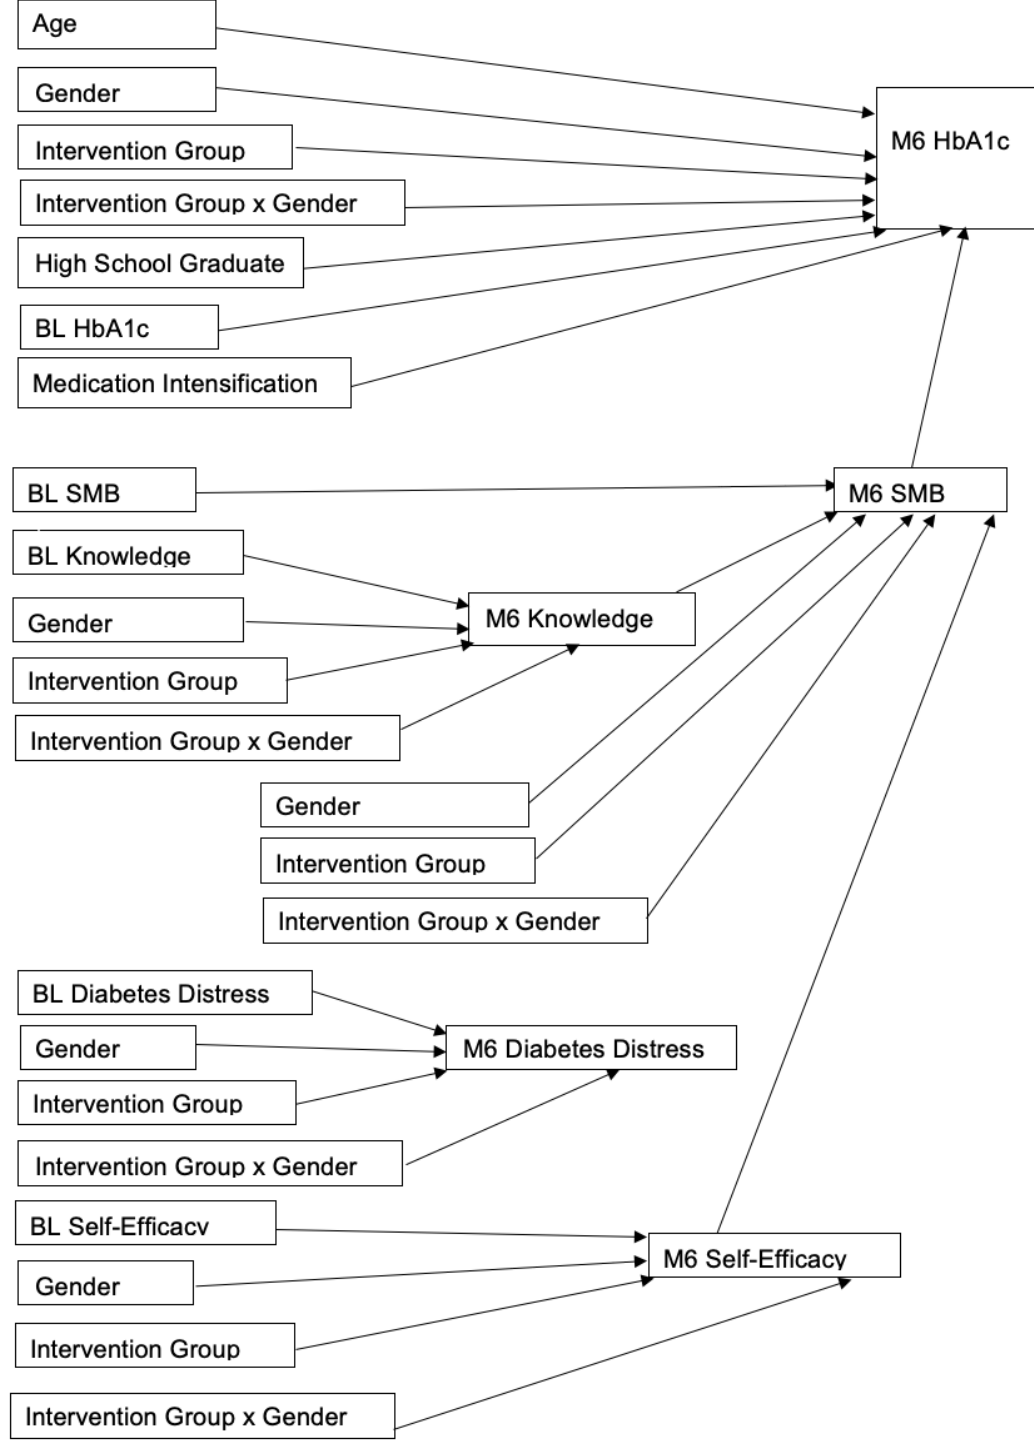
Figure 1. Path Analysis with covariates